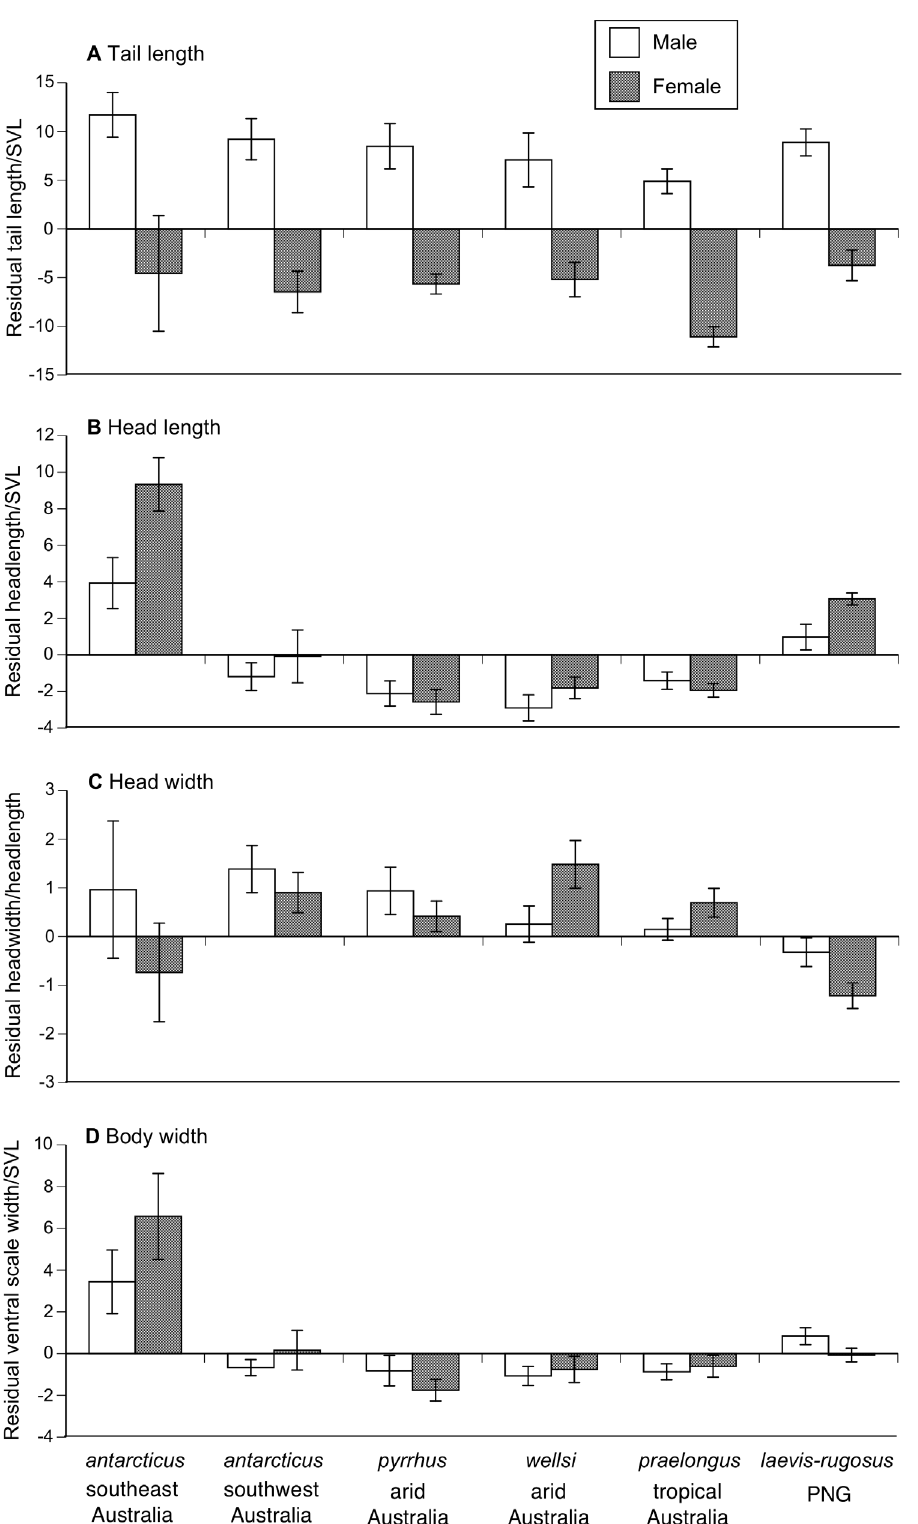
Figure 3. Interspecific and sexual variation in morphological traits in museum specimens of death adders (genus Acanthophis ). The graphs show residual scores from general linear regressions to show (A) relative tail length (from the regression of tail length to snout-vent length), (B) relative head length (from the regression of head length to snout-vent length), (C) relative head width (from the regression of head width to head length), (D) relative ventral scale width (from the regression of ventral scale width to snout-vent length). Graphs show mean values and associated standard errors.